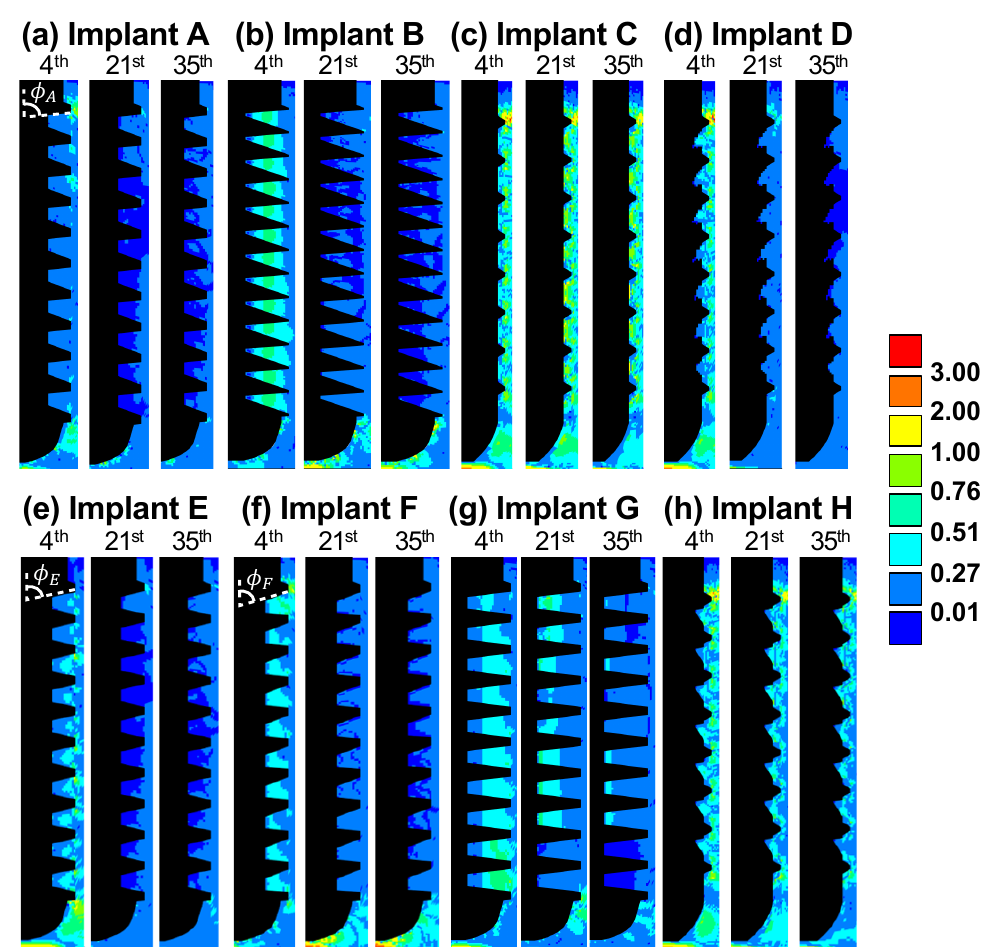
Figure 4. ( a – h ) The contour plots of fluid stimulus for implants A to H, on the 4th, 21st, and 35th